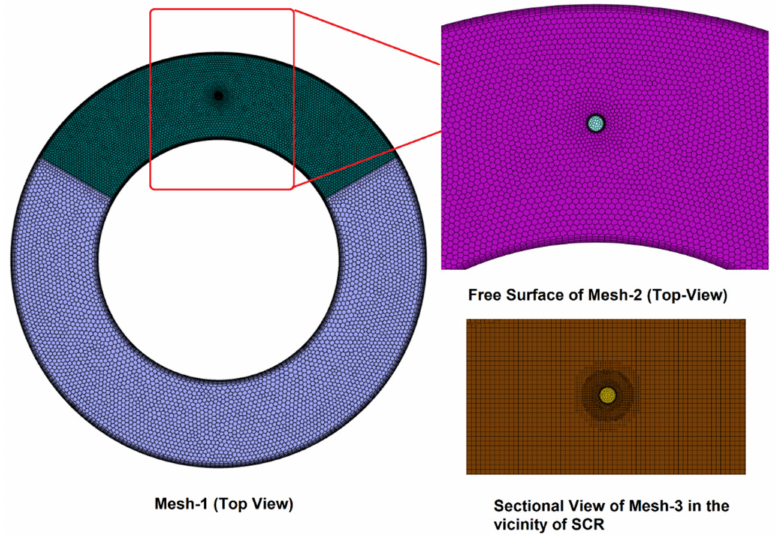
Figure 2. Various grids employed in the current study for mesh sensitivity, showing top views and sectional view of the